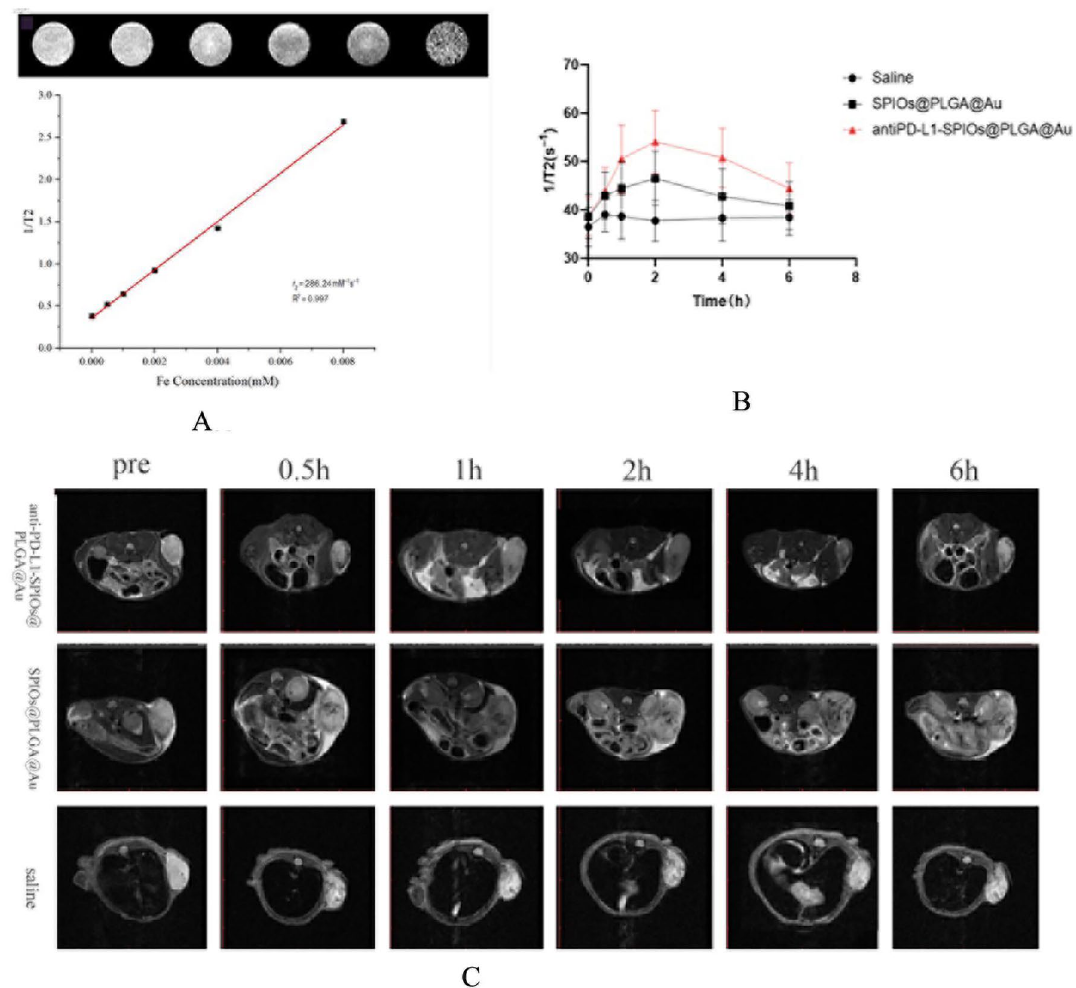
Figure 2. ( A ) T 2 -weighted MR images of antiPD-L1-SPIOs@PLGA@Au with increasing Fe concentrations; ( B ) T 2 relaxation rate (1/T 2 (s-1)) corresponding to region of interest of tumor at different time points (0 h, 0.5 h, 1 h, 2 h, 4 h, 6 h) with different injections. ( C ) T 2 -weighted MR images of a B16F10 mice xenograft tumor at different time